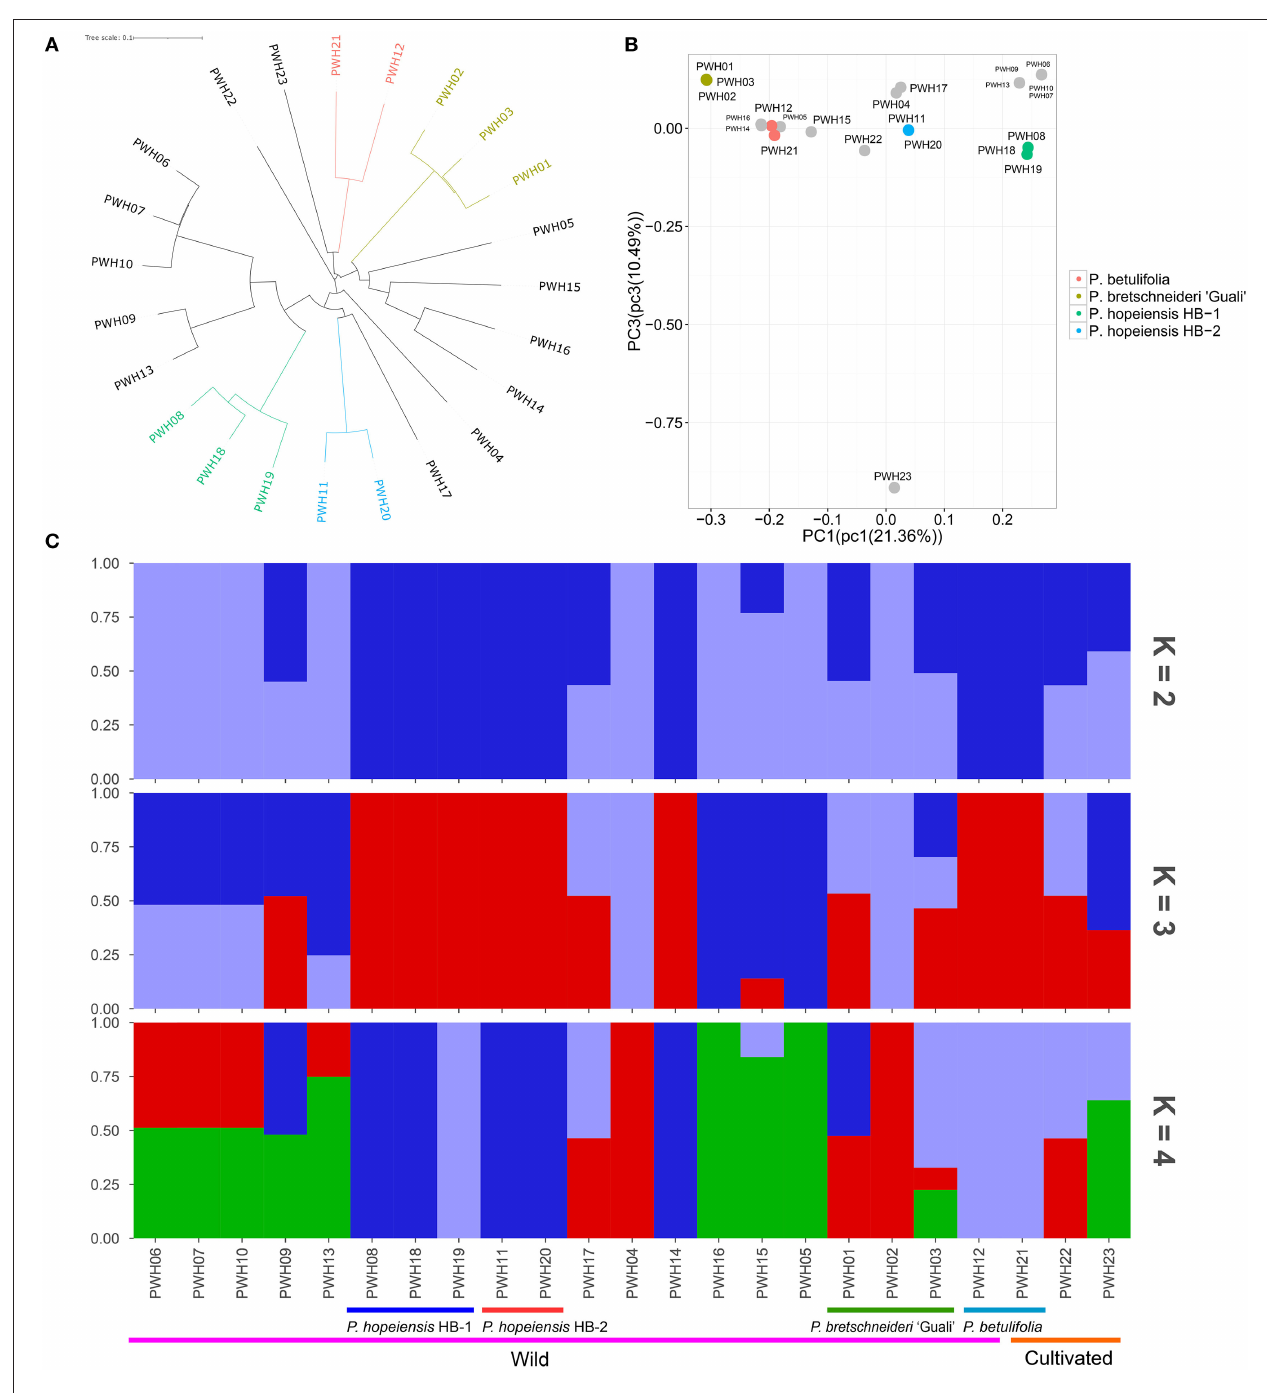
FIGURE 7 | Population structure. (A) Neighbor-joining phylogenetic tree constructed using SNP data. (B) Principal component analysis (PCA) of the 23 Pyrus accessions. (C) Population structure ( K = 2–4) of the 23 Pyrus accessions.